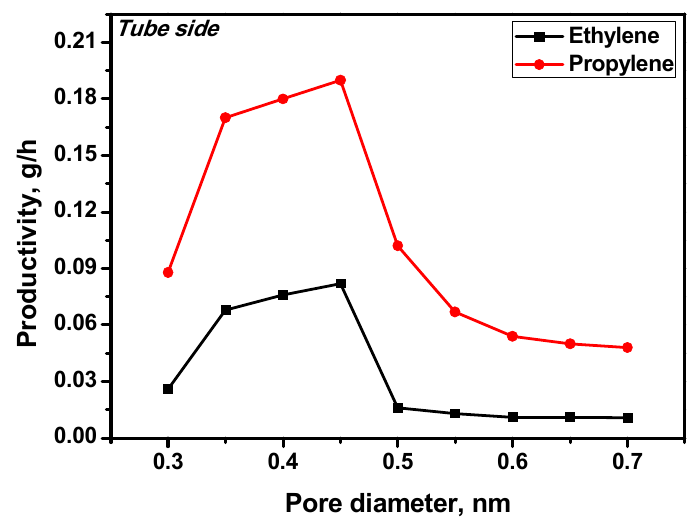
Figure 10. Productivity of olefins depending on the membrane pore diameter.